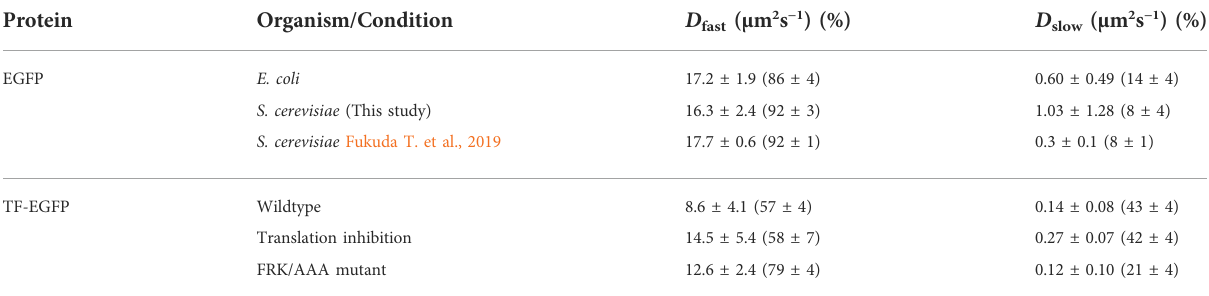
TABLE 1 Apparent diffusion coef fi cients ( D ) of GFP and GFP-fused trigger factor (TF) in vivo .